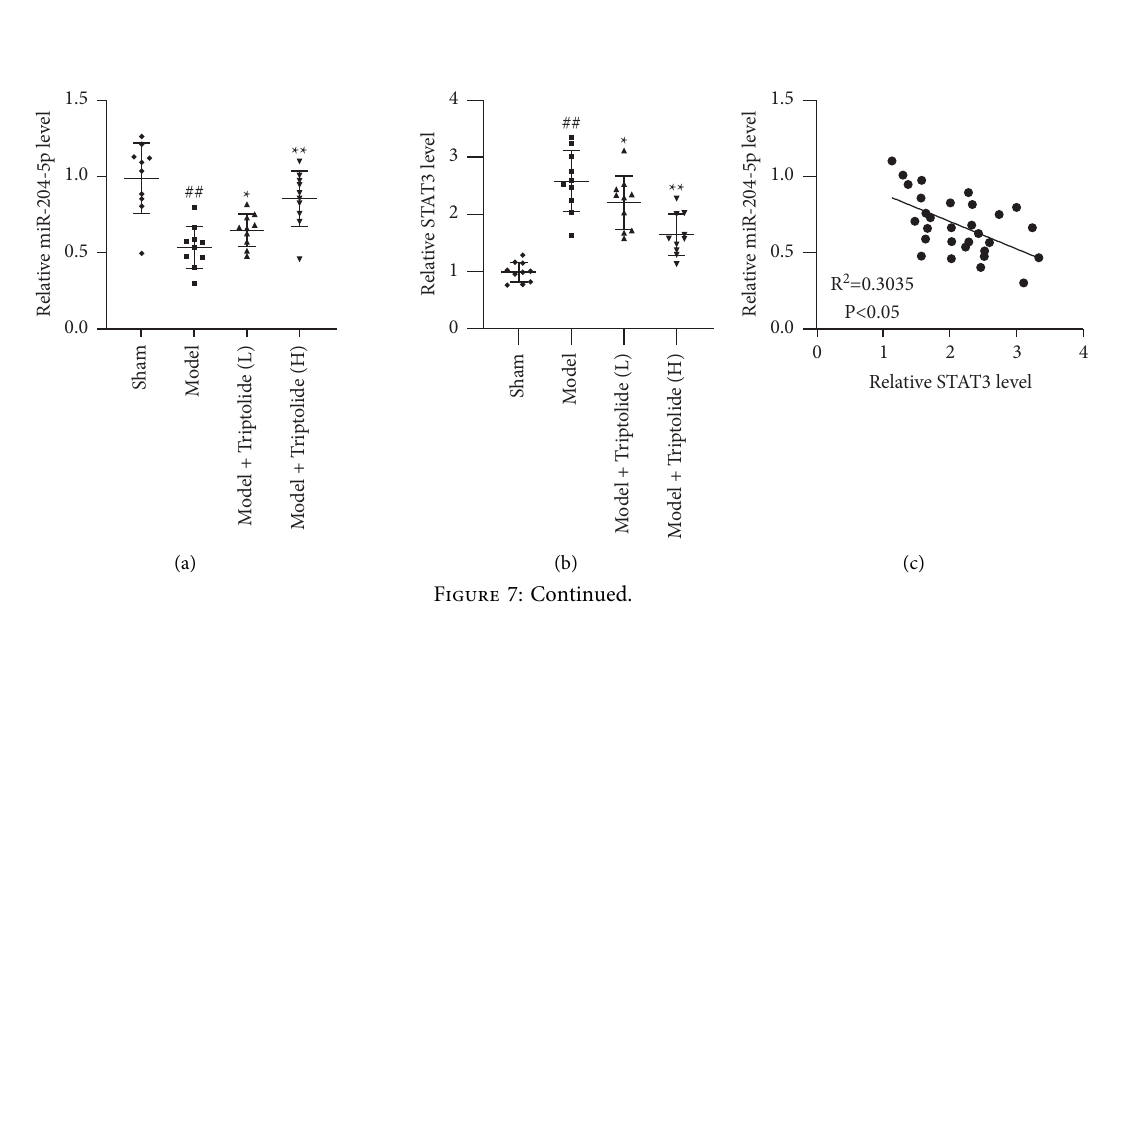
Figure 6: Triptolide suppresses proinfammatory cytokine expression in IMQ-induced psoriatic mice. (a and b) Serum concentrations of IL- 17 and IFN- c in IMQ-induced psoriatic mice detected by ELISA after triptolide treatment for 8 days. (c–f) Te mRNA expression of proinfammatory cytokines in psoriasis-like lesions also detected via RT-qPCR on day 8. Each column is representative of data obtained from a minimum of 8 animals. ## P < 0 . 01 compared to the sham group; ∗ P < 0 . 05, ∗∗ P < 0 . 01 compared to the model